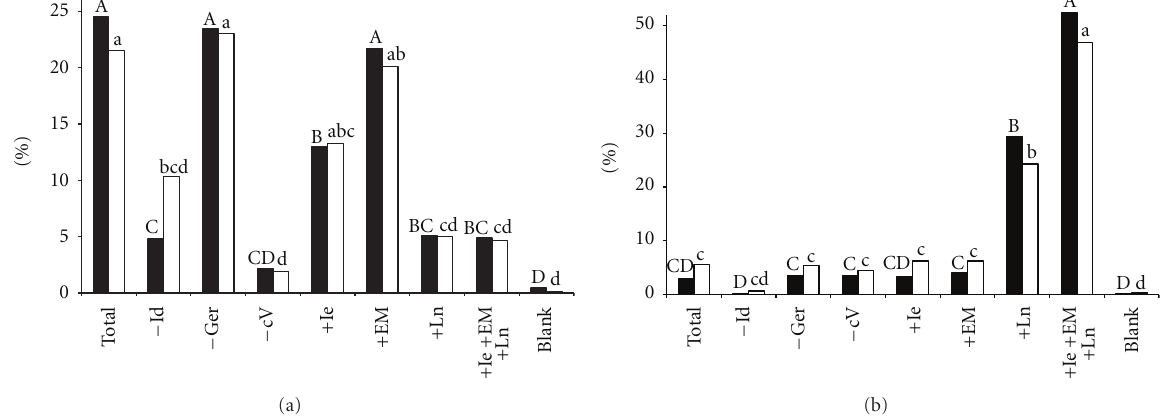
Figure 5: Percentage trap catches in a subtractive and additive field bioassay of I. calligraphus -bait: (a) I. calligraphus , and (b) I. avulsus . (for bait information, see Table 3). (cid:2) females; (cid:3) males. Bars with same letter are not significantly di ff erent. n = 6; total trap catches: I. calligraphus 523 ♀♀ , 378 ♂♂ ; I. avulsus 225 ♀♀ , 183 ♂♂ .